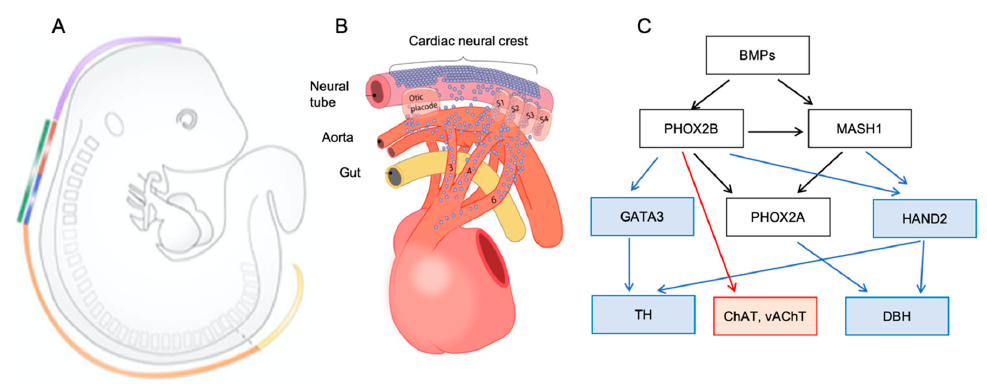
Figure 2. ( A ) Regionalization of the neural crest along the dorsal neural tube of the mouse embryo (E10.5): cranial (purple), vagal (green), trunk (orange), and sacral (yellow). Vagal neural crest cells (NCCs) are further subdivided into: cardiac (red) and enteric (blue) lineages. ( B ) Migration of cardiac NCCs through or lateral to the somites into the branchial arch arteries and further into the outflow tract. ( C ) Transcriptional network involved in the specification and di ff erentiation of NCCs into sympathetic and parasympathetic neurons. White box: factors involved in both pathways; blue: factors involved in the di ff erentiation of sympathetic neurons and red: of parasympathetic neurons. Abbreviations: BMPs- bone morphogenic proteins; ChAT- choline acetyltransferase; DBH- dopamine β -hydroxylase; GATA3- GATA binding protein 3; HAND2: heart and neural crest derivative expressed 2; MASH1- mammalian achaete-scute homologue; PHOX2 (A or B)- paired-like homeobox 2A or 2B; TH- tyrosine hydroxylase; vAChT- vesicular acetylcholine transporter. ( A ) reproduced with permission from Hutchins, E.J., et al. Dev. Biol published by Elsevier 2018 [29]; ( B ) reproduced with permission from V é gh A.M.D., et al. JCDD by MDPI 2016 [10]; ( C ) adapted from V é gh A.M.D., et al. JCDD by MDPI 2016